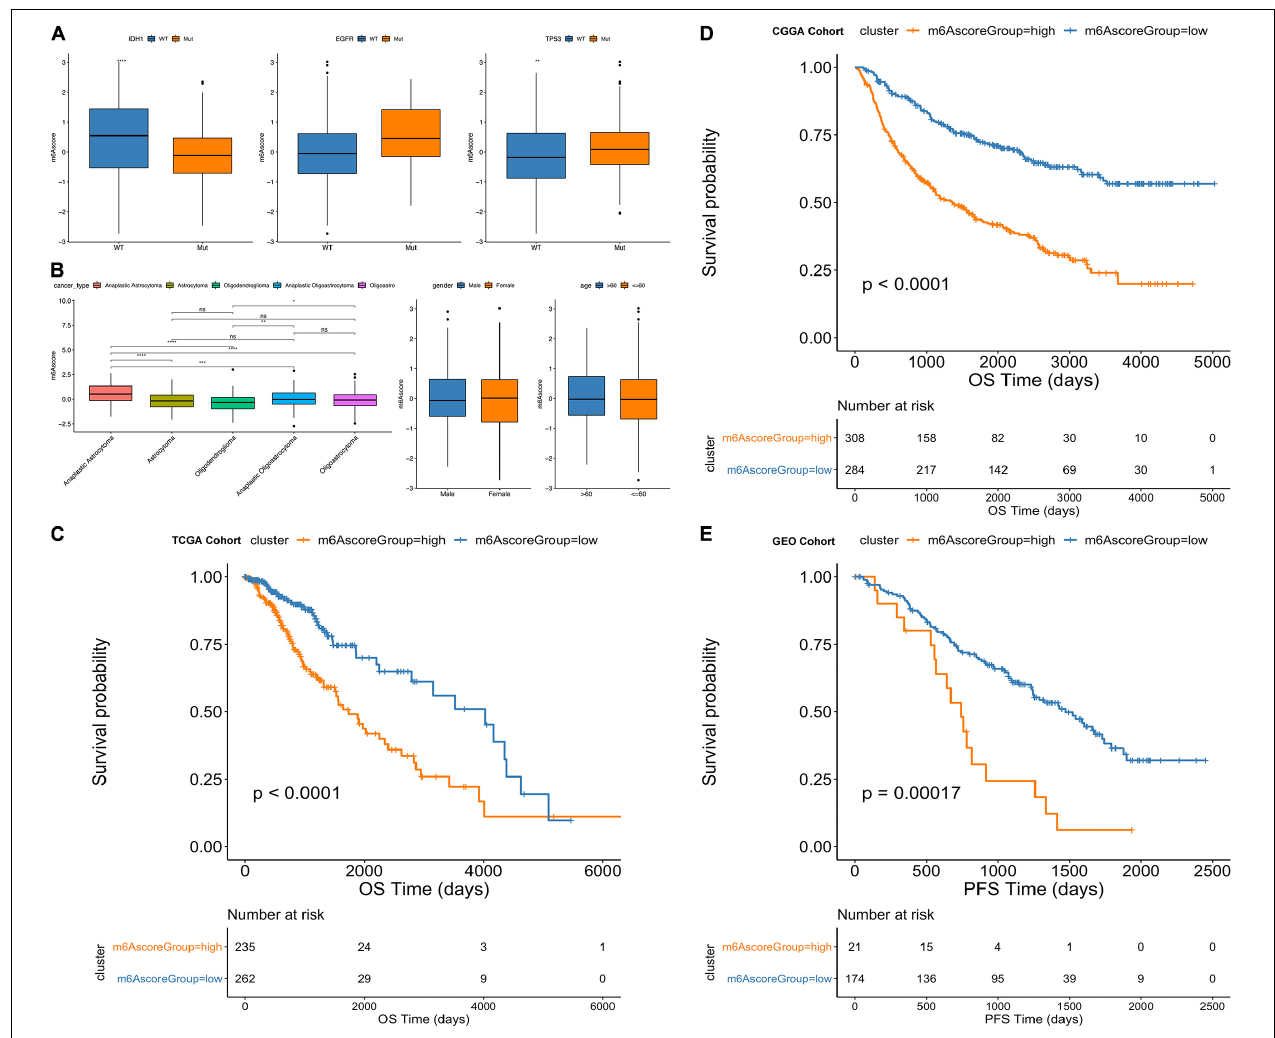
FIGURE 7 | Comparative analysis and model verification of m6Ascore in TCGA dataset. (A–D) Distribution of m6Ascore in different classification subgroups. (A) IDH1, EGFR, TP53. (B) Cancer type. (C) Gender. (D) Age. (E) Difference in survival between m6Ascore high and low groups in the TCGA samples. ( p <